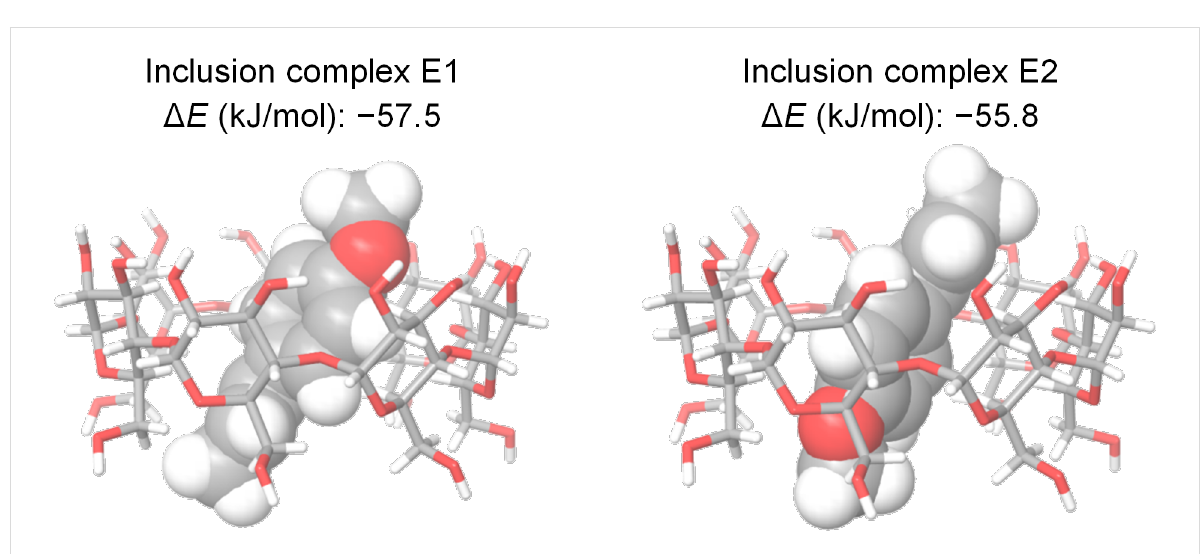
Figure 4: Representation of the most stable CD/ trans -anethole inclusion complex conformers resulting from the two docking strategies.